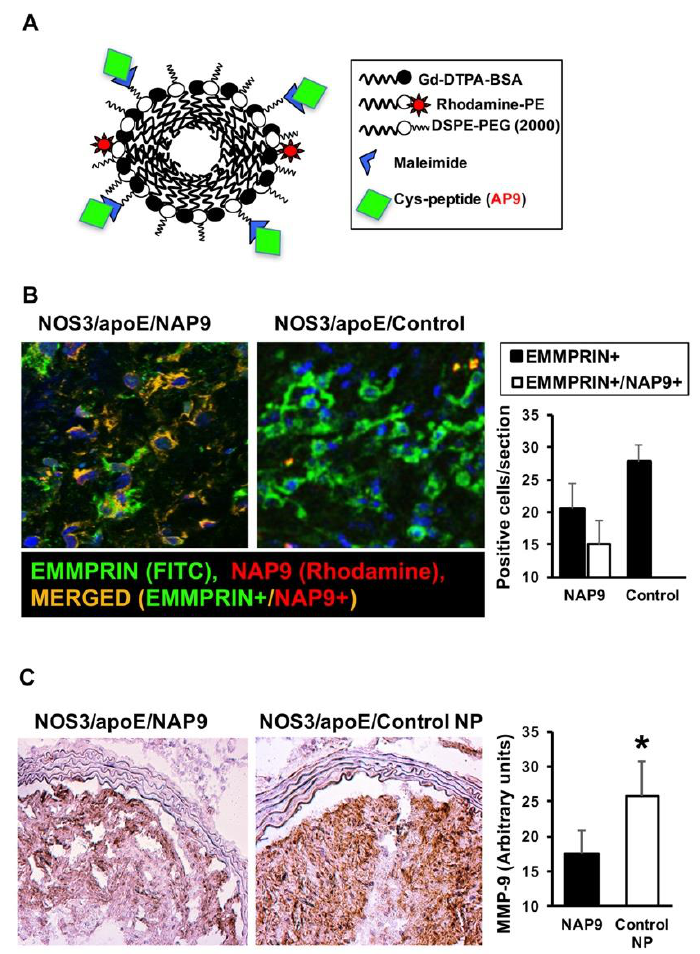
Figure 3. NAP9 nanoparticles (NP) bind to EMMPRIN in carotid atherosclerosis from NOS3/apoE knockout mice. ( A ) Composition of NAP9 micelles containing AP9 peptides. ( B ) Confocal microscopy detection of EMMPRIN (FITC, green) and NAP9 (Rhodamine, red), in carotid sections of NOS3/apoE null mice injected with 0.1 mg/kg/day NAP9 or saline (Control). Merged panels show co-localization of both signals ( N = 10 mice, mean ± standard deviation (SD)). ( C ) Immunohistochemical detection of MMP-9 in NOS3/apoE double knockout (KO) mice injected with 0.1 mg/kg/day NAP9 or Control NP. ( N = 10 mice, NAP9: 17.65 ± 3.255 vs. Control NP: 25.73 ± 5.077. * P : 0.002).